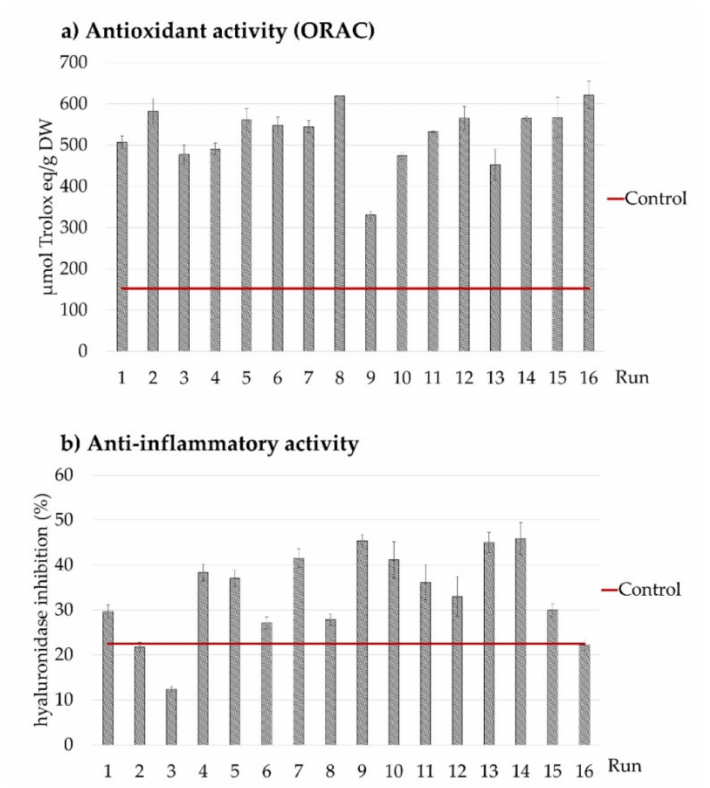
Figure 5. Antioxidant ( µ mol trolox eq./g dry weigh) and anti-inflammatory activity (% hyalunoronidase inhibition) of the extracts obtained at 5 min UAE time compared to extract obtained with homogenization